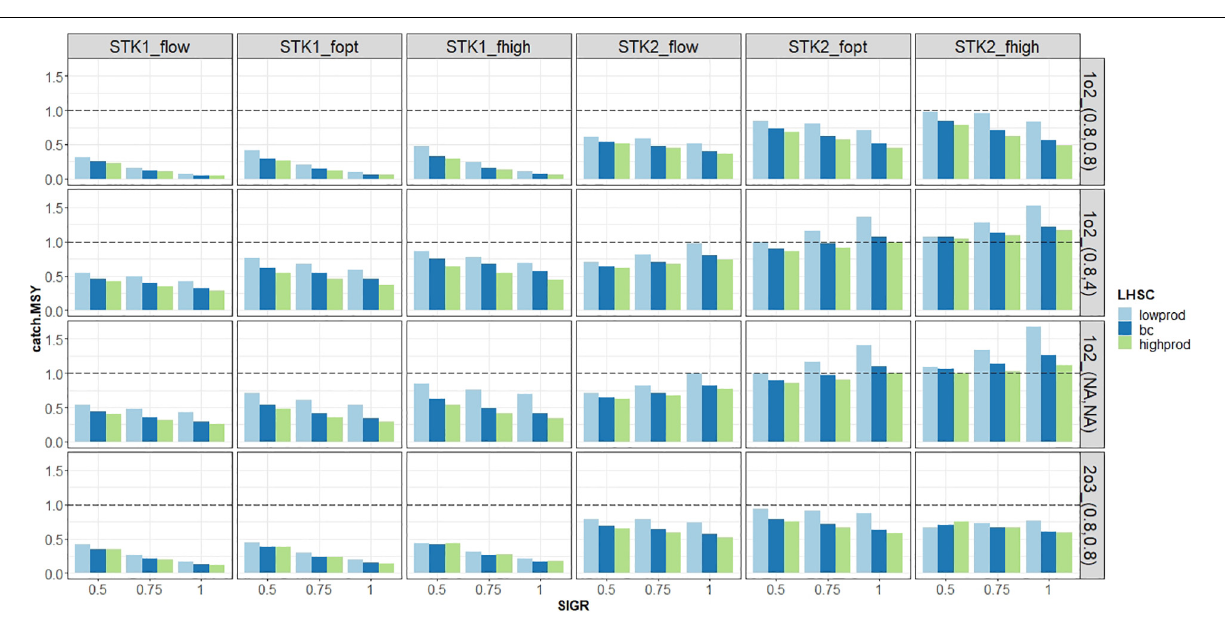
FIGURE 13 | Relative yields (catches/MSY) in the long-term (last 10 projection years) versus the standard deviation of recruitment (x-axis) and stock productivity (colours) under an in-year advice. The columns correspond to the different OMs (as combination of the stock-type and historical exploitation) and the rows to the configurations of the rule (harvest control rule type and uncertainty cap lower and upper limits). Dashed line corresponds to catches equal to MSY. See Table 1 for definitions of abbreviations. Interactive version of the figure is available online at